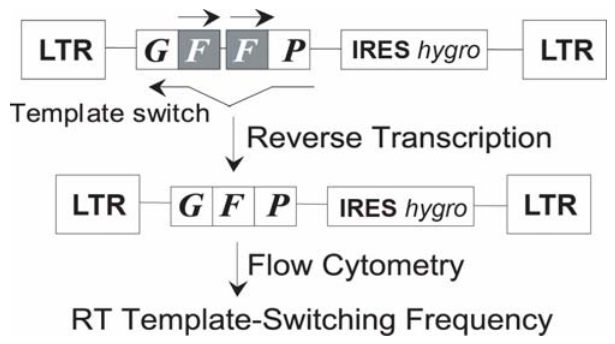
Figure 2. Single-cycle direct repeat deletion assay to determine the percentage of template switching in vivo . Proviruses containing a direct repeat (horizontal arrows) of the green fluorescent protein gene (GFP) were mobilized and used to infect target cells. The frequency of a homologous template switch during reverse transcription in target cells, which reconstitutes a functional GFP gene, was measured by flow cytometry. IRES, internal ribosomal entry site; hygro , hygromycin gene; LTR, long terminal